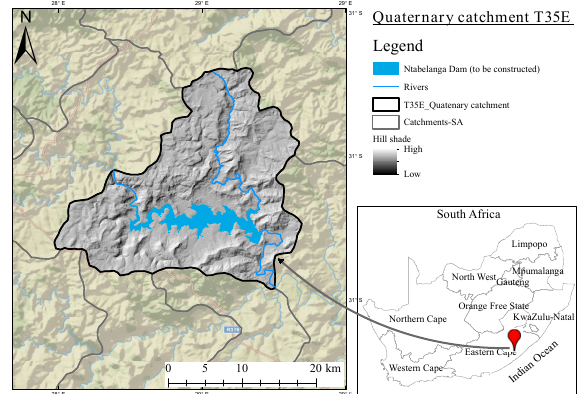
Figure 1. Location of study area: Tsitsa River Catchment, Eastern Cape, South